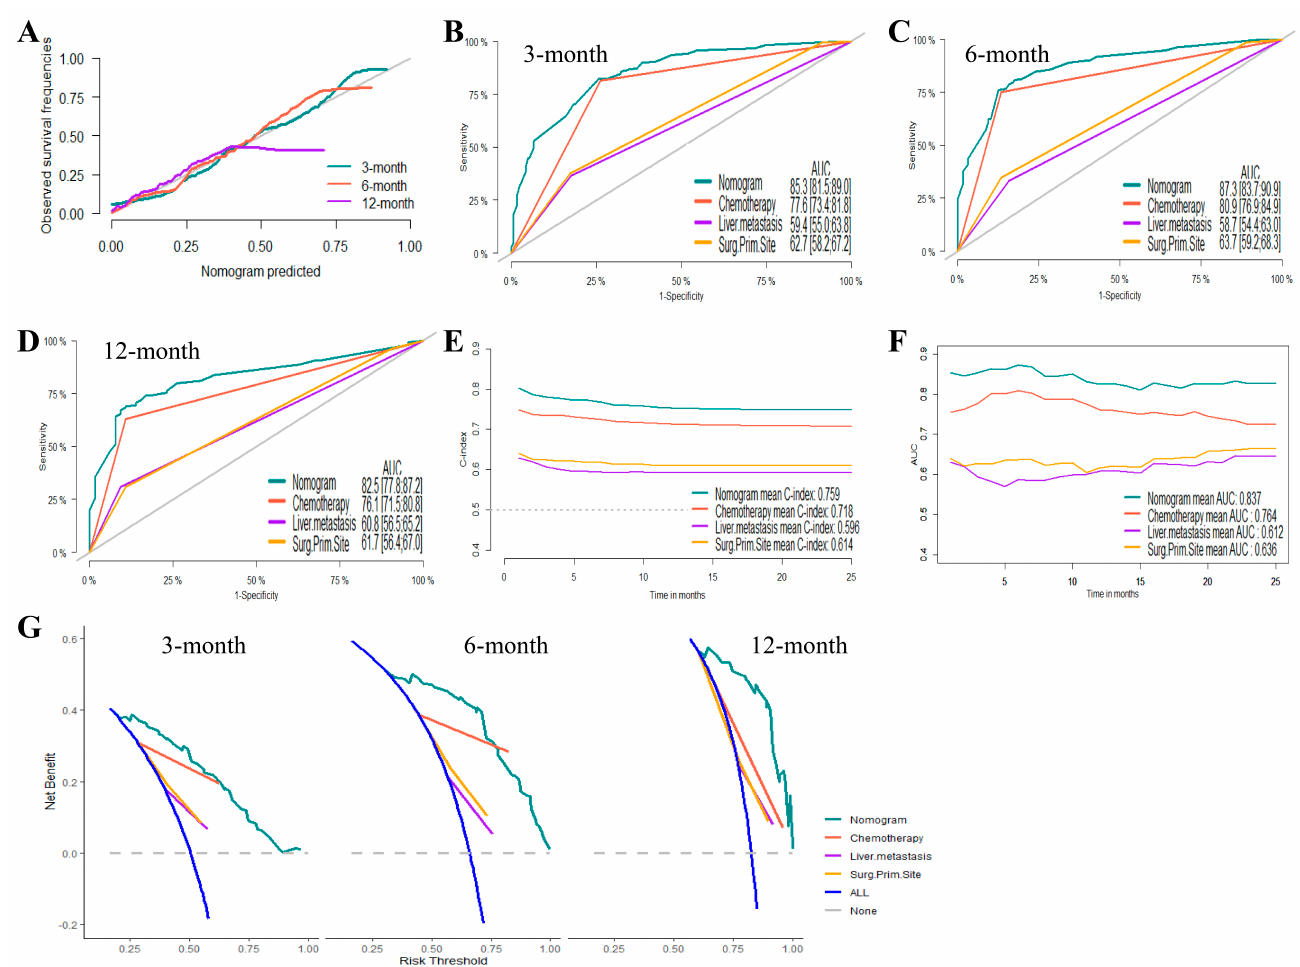
Figure 3. Evaluation of the nomogram on the internal validation dataset for overall survival (OS). ( A ) 3-, 6-, and 12-month calibration plots of nomogram; ( B ) 3-month; ( C ) 6-month; and ( D ) 12-month area under the curve (AUC) for receiver operating characteristic (ROC) curves of nomogram, chemotherapy, liver metastasis, and primary site surgery; ( E ) overall concordance index (c-index) of nomogram, chemotherapy, liver metastasis, and primary site surgery; ( F ) overall AUC of nomogram, chemotherapy, liver metastasis, and primary site surgery; ( G ) 3-, 6-, and 12-month decision curve analysis (DCA) of nomogram, chemotherapy, liver metastasis, and primary site surgery.